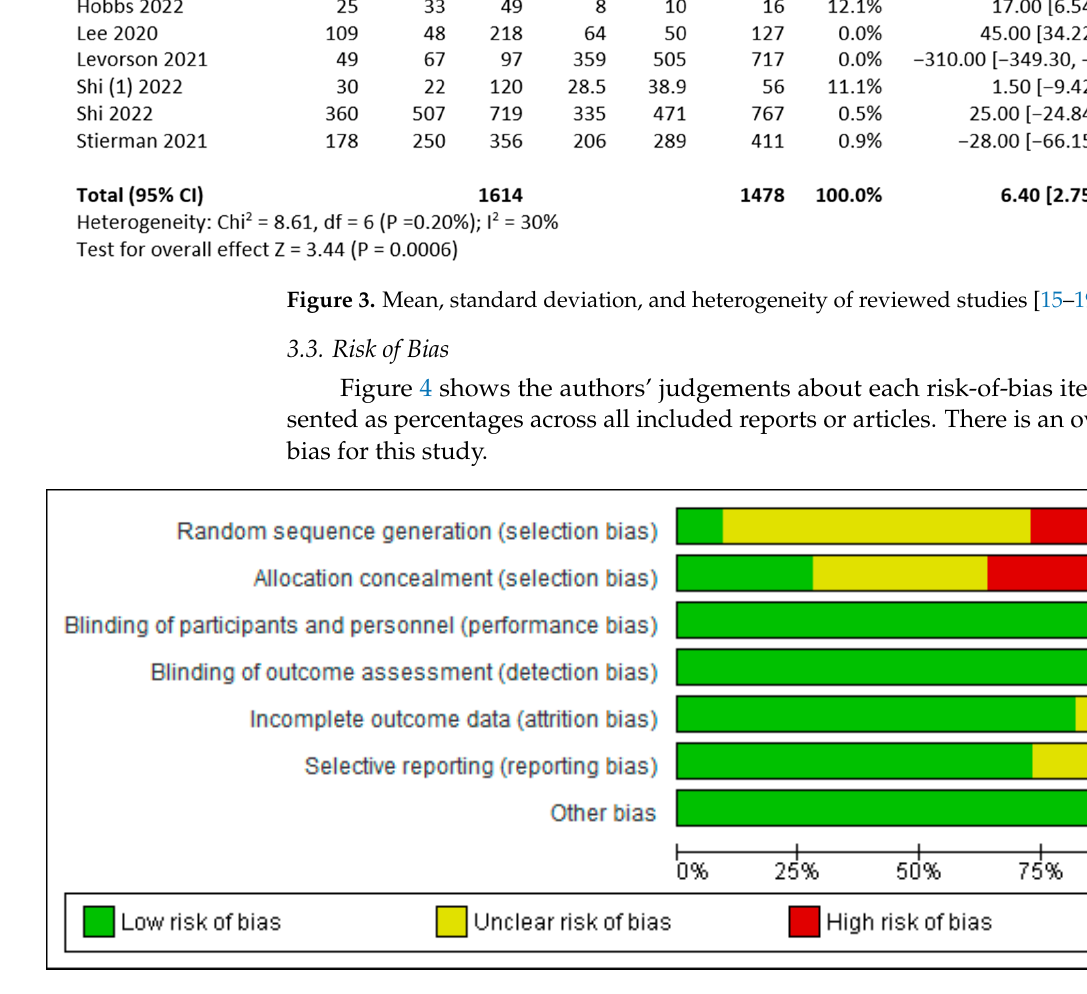
Figure 4. Risk of bias as assessed in 10 studies.